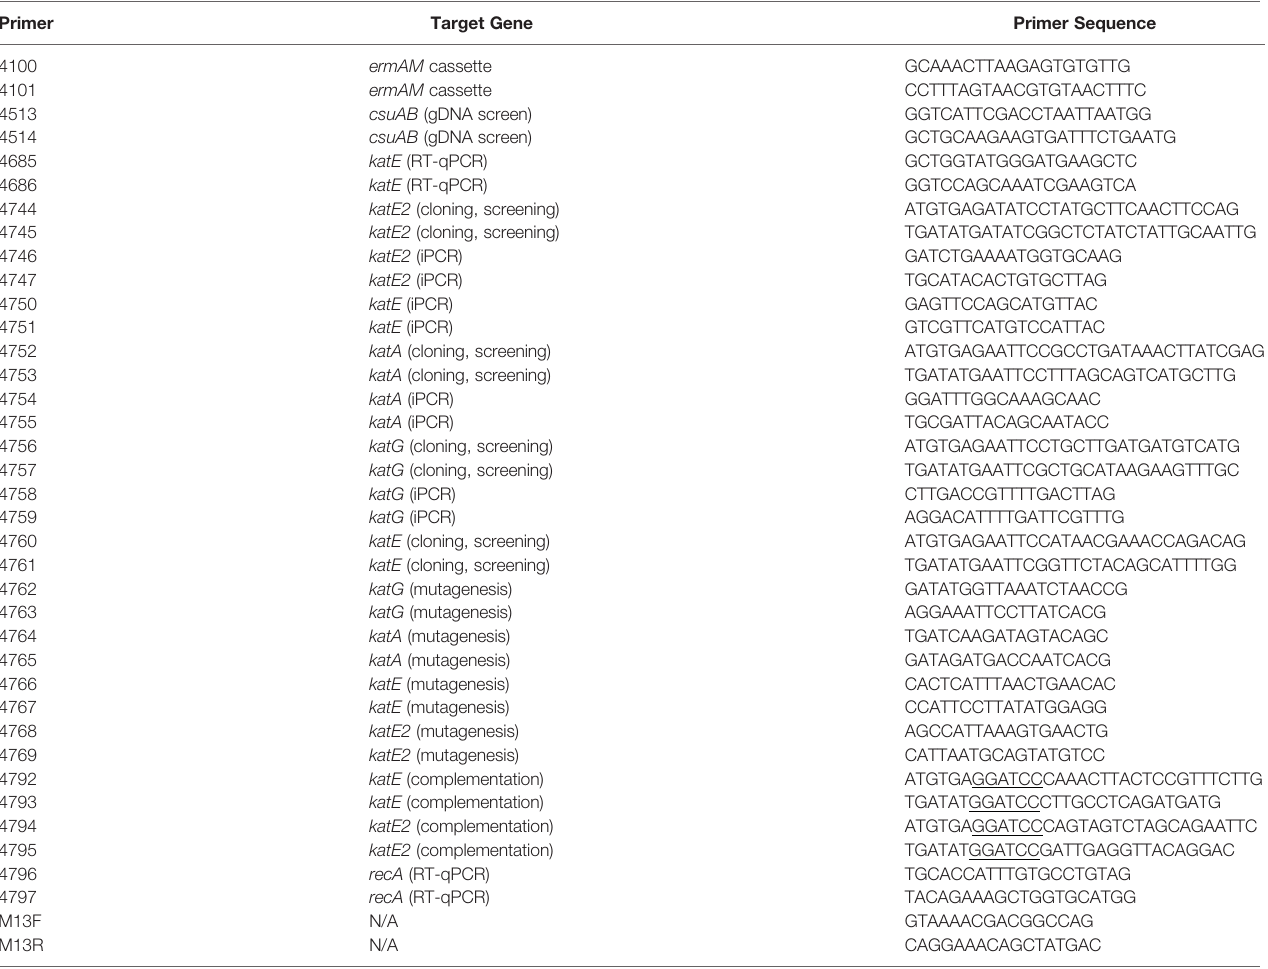
TABLE 2 | Primers used in this